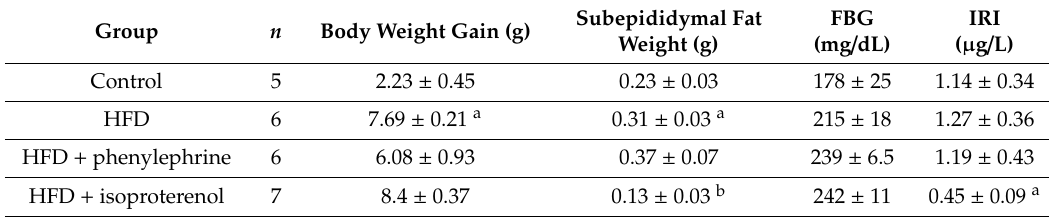
Table 1. Clinical characteristics of mice fed experimental